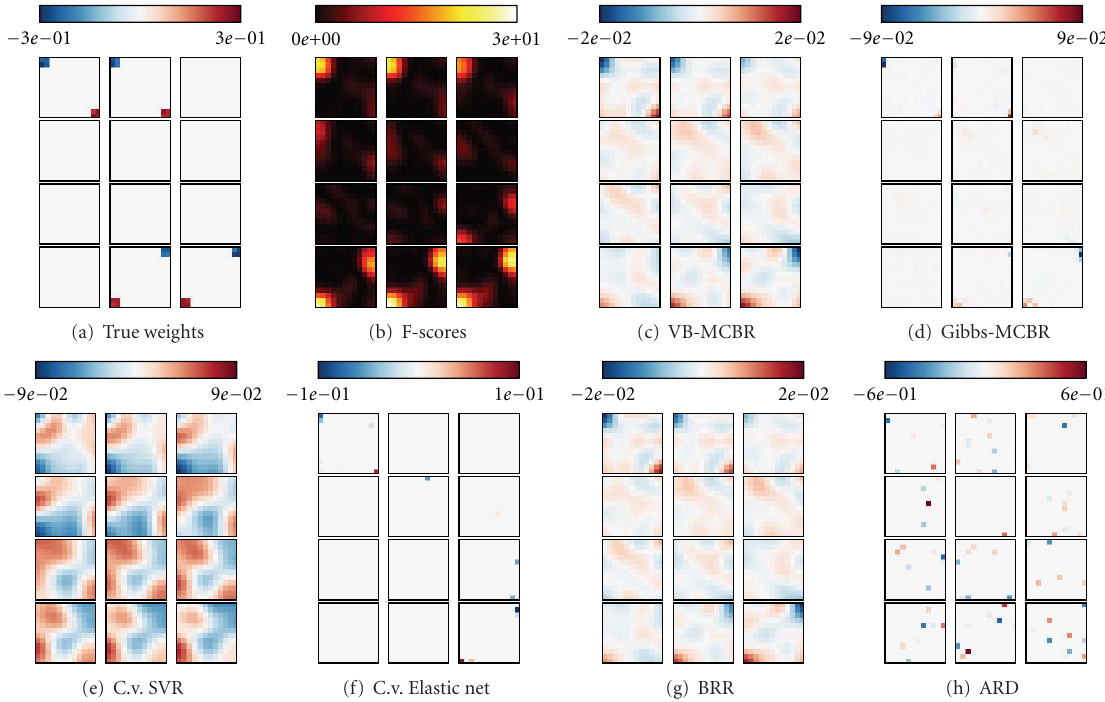
Figure 4: Two-dimensional slices of the three-dimensional volume of simulated data. Weights found by di ff erent methods, the true target (a) and F-score (b). The Gibbs-MCBR method (d) retrieves almost the whole spatial support for the weights. The sparsity-promoting reference methods, elastic net (f) and ARD (h), find an overly sparse support of the weights. VB-MCBR (c) converges to a local maximum similar to BRR (g) and thus does not yield a sparse solution. SVR (e) yields smooth maps that are not similar to the ground